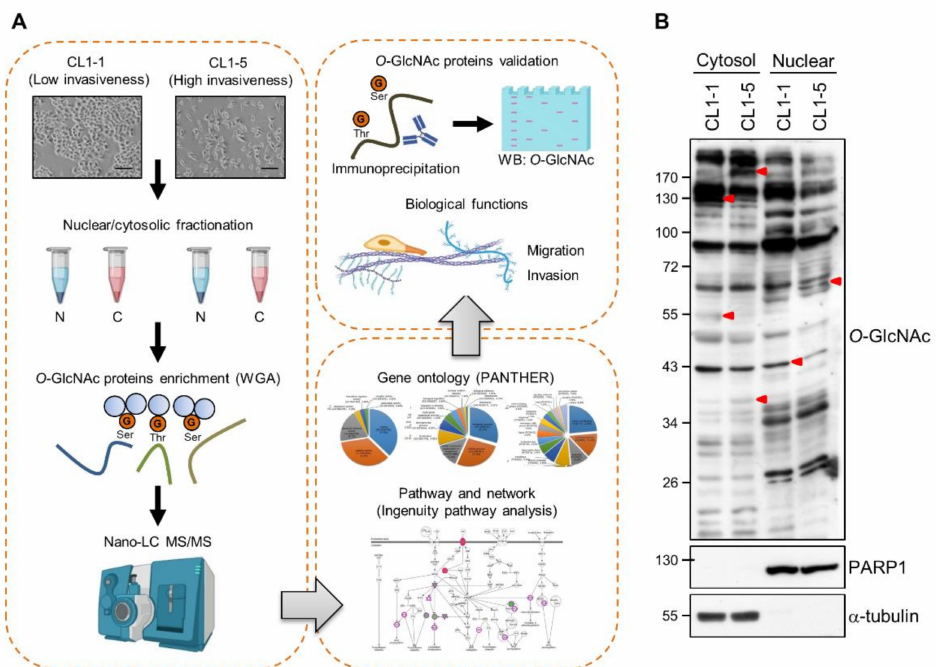
Figure 1. Profiling of the O -GlcNAc proteomes of two differentially invasive lung adenocarcinoma cell lines. ( A ) A schematic workflow of this study. Lysates were prepared from subconfluent lowly invasive CL1-1 and highly invasive CL1-5 cells and fractionated into nuclear (N) and cytosolic ( C ) extracts. O -GlcNAcylated proteins were enriched using resin-bound wheat germ agglutinin (WGA). Tryptic peptides of WGA-bound proteins were subjected to nano-LC-MS/MS. Reproducibly identified differential WGA-bound proteins were further analyzed in silico using bioinformatics tools including PANTHER Gene Ontology and Ingenuity pathway analysis. Selected differential WGA-bound proteins were further validated and characterized for roles in cancer cell migration and invasion. ( B ) Representative results of Western analysis of cytosolic and nuclear exacts of CL1-1 and CL1-5 cells. Proteins were separated by 10% SDS-PAGE and subjected to Western blotting using antibodies for O -GlcNAc, PARP1 (a nuclear protein marker) and α -tubulin (a cytosolic protein marker). Arrowheads point to examples of differential bands between CL1-1 and CL1-5 samples. Detailed information about the Western blotting can be found in Figure S7. PANTHER,